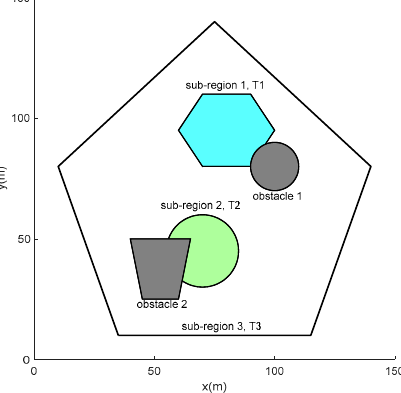
Figure 15. The distribution of the task environment.